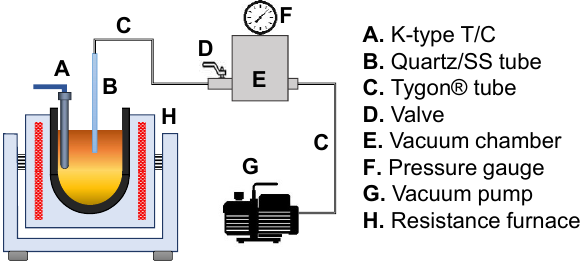
Figure 1. Schematic diagram of the experimental apparatus of the present suction fluidity